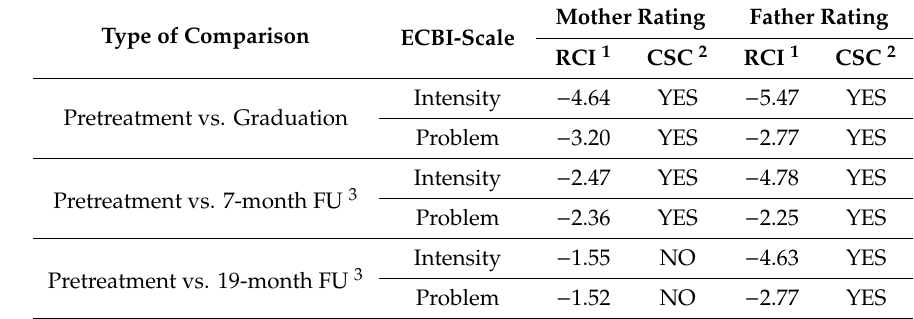
Table 3. Reliable Change Indices and Clinically Significant Changes at graduation, 7- and 19-month follow-up. Type of